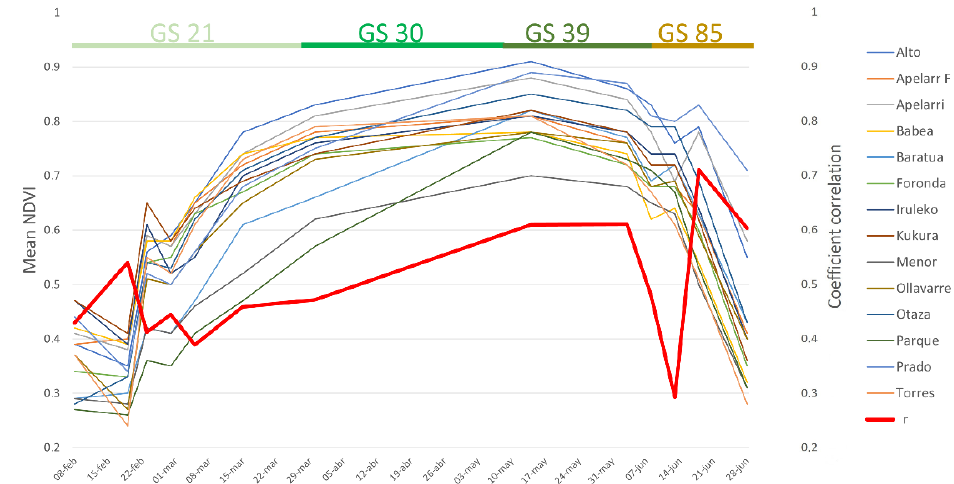
Figure 3. Seasonal trend in NDVI data of the 14 plots over the 2019 season. The thick red line shows changes in the Pearson correlation coefficient (r) between NDVI and yield (Torres plot not included). GS refers to the wheat growth stage. GS21 Tillering, GS31 Stem elongation, GS39 Heading, and GS85 Ripening.